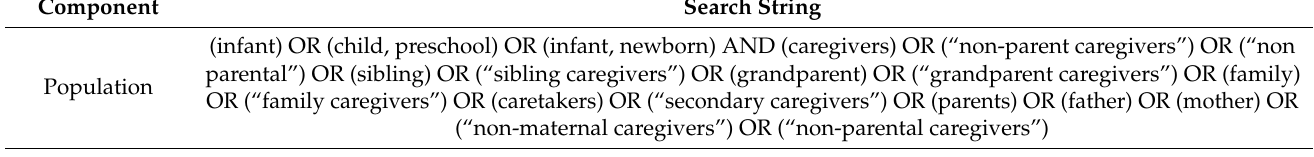
Table 1. Search strategy. Component Search